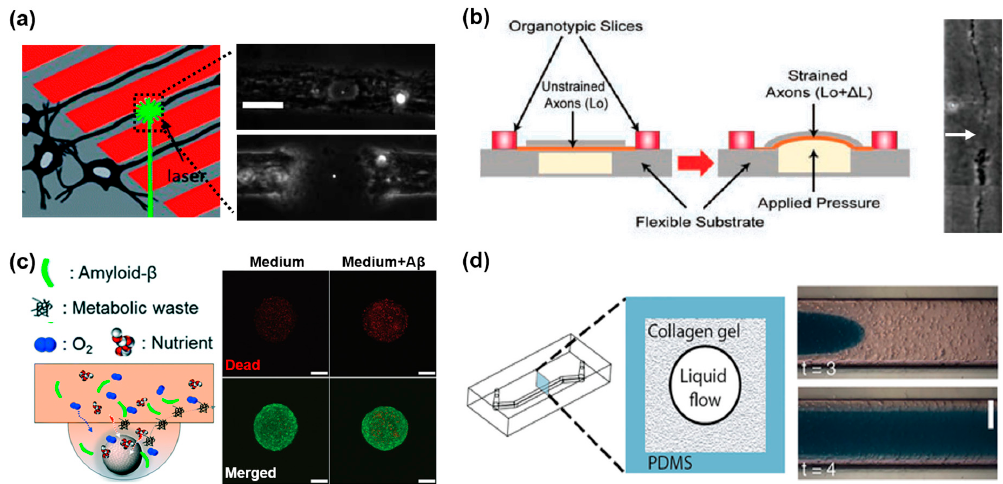
Figure 4. In vitro microfluidic devices for mimicry the neurodegeneration and neural stem cell (NSC) differentiation. ( a ) Axonal injury model by laser induced axotomy to provide precise damage to selected neurons. Reproduced with permission [92]. Copyright 2010, Royal Society of Chemistry; ( b ) Diffused axonal injury model in a microdevice with a flexible substrate, which can apply pressure to damage neuron. Arrow indicates the axonal degeneration 20 h post injury. Reproduced with permission [93]. Copyright 2014, World Scientific; ( c ) Alzheimer’s disease brain mimicking microfluidic chip, which consists of neurospheroids, are cultured under normal medium containing oxygen, nutrient, and 5 µ M synthetic amyloid- β (1–42). Reproduced with permission [62]. Copyright 2015, Royal Society of Chemistry; ( d ) The pressure-driven microfluidic model to generate the cylindrical collagen gel channel in the 3D BBB chip. A continuous hollow cylindrical lumen channel was utilized as the microvasculature with a vascular endothelium. Reproduced with permission [96]. Copyright 2016, Herland et